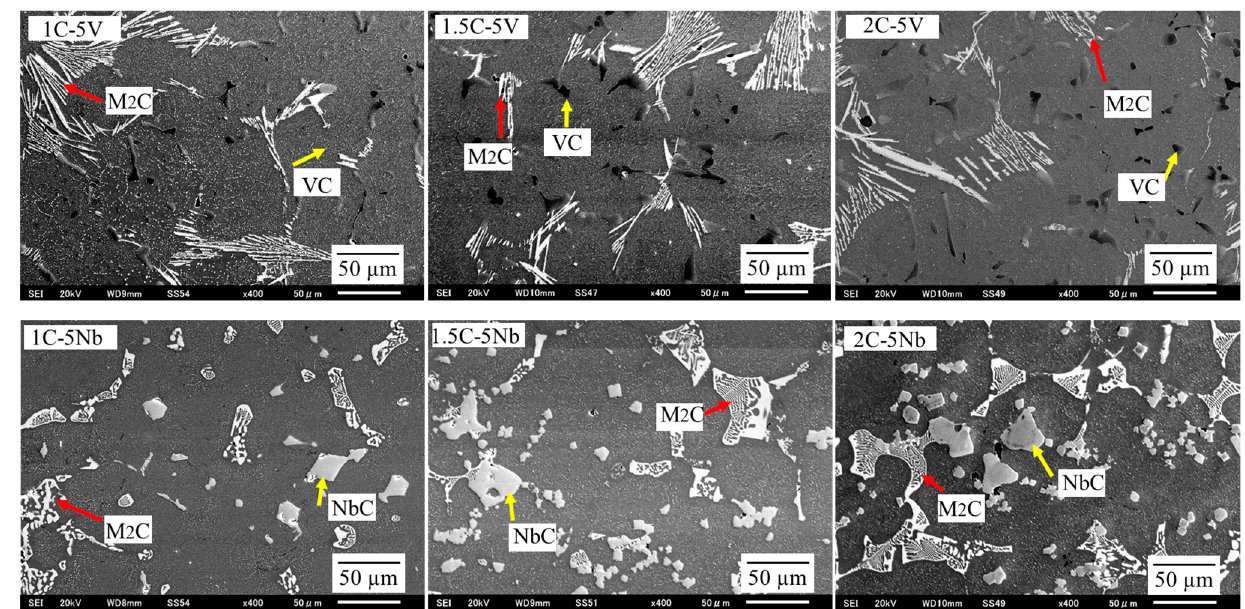
Figure 4. The microstructure of each alloy obtained by SEM. The VC (mainly globular shape) and M 2 C (fiber-like shape) carbides are precipitated on the microstructure of the 5V alloy. Meanwhile, the NbC (rectangular shape) and M 2 C (fishbone-like shape) carbides are deposited on the microstructure of the 5Nb alloy.